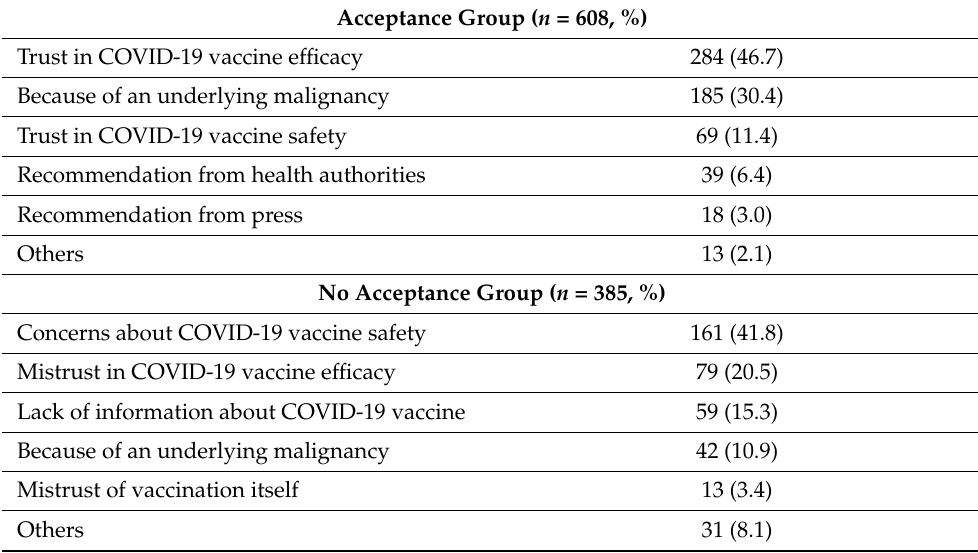
Table 3. Respondents’ reasons for accepting or not accepting COVID-19